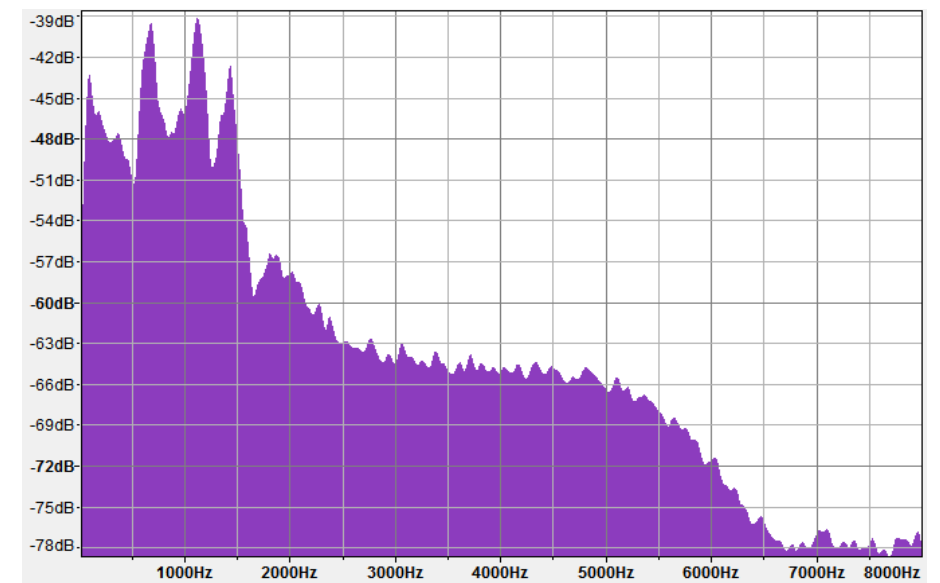
Figure 3. FFT of signal from Figure